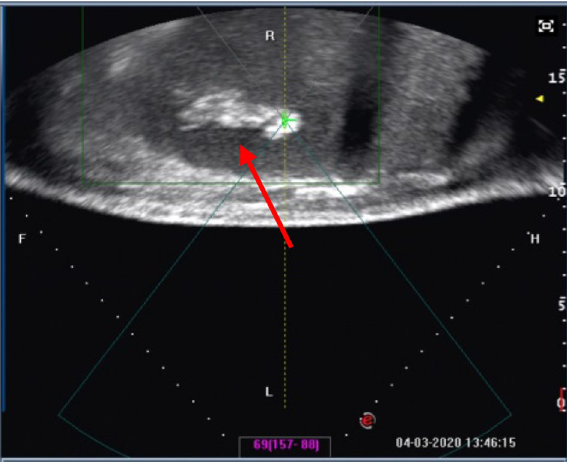
Figure 1. Real-time grayscale sonographic changes during high-intensity focused ultrasound treatment. The real-time sonography showed a hyperechoic area in the HIFU treated region of the spleen (red arrow).